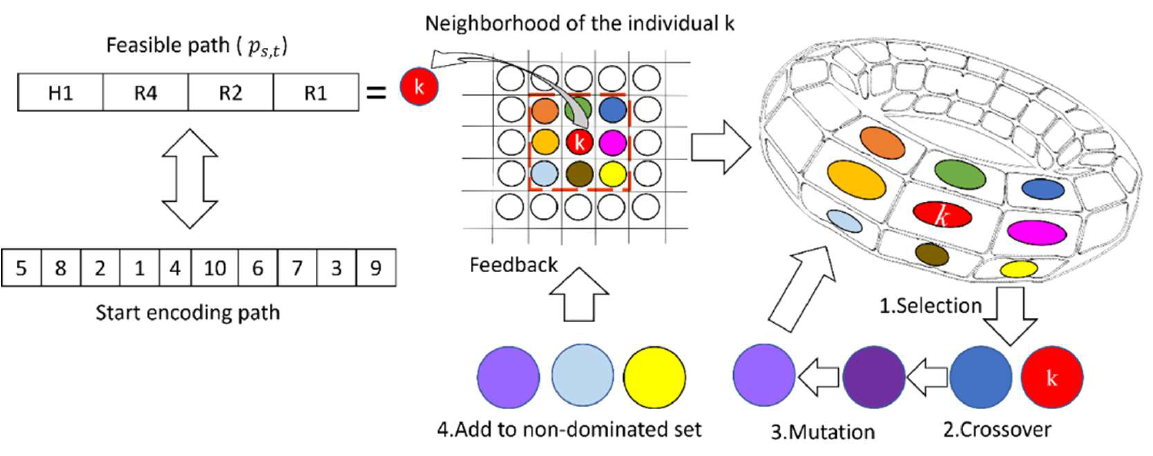
Figure 3. MOCell Figure 3. MOCell algorithm. Algorithm 2. Pseudocode of metaheuristic based on MOCell